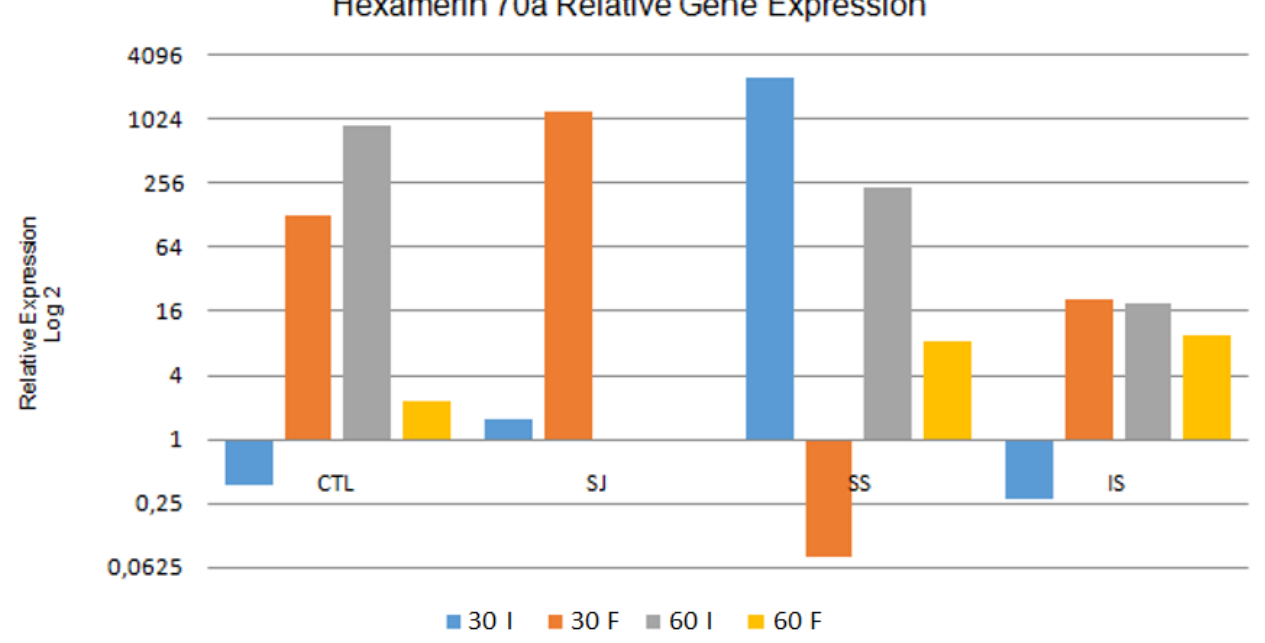
Figure 2. Relative expression of the hexamerin 70a gene in intern bees (I) and forager bees (F), after 30 days and 60 days, under the different treatments. CTL: control; SJ: sugarcane juice; SS: sugar syrup; IS: inverted sucrose. 60 I and 60 F: Data not obtained due to death of the colonies during the experimental